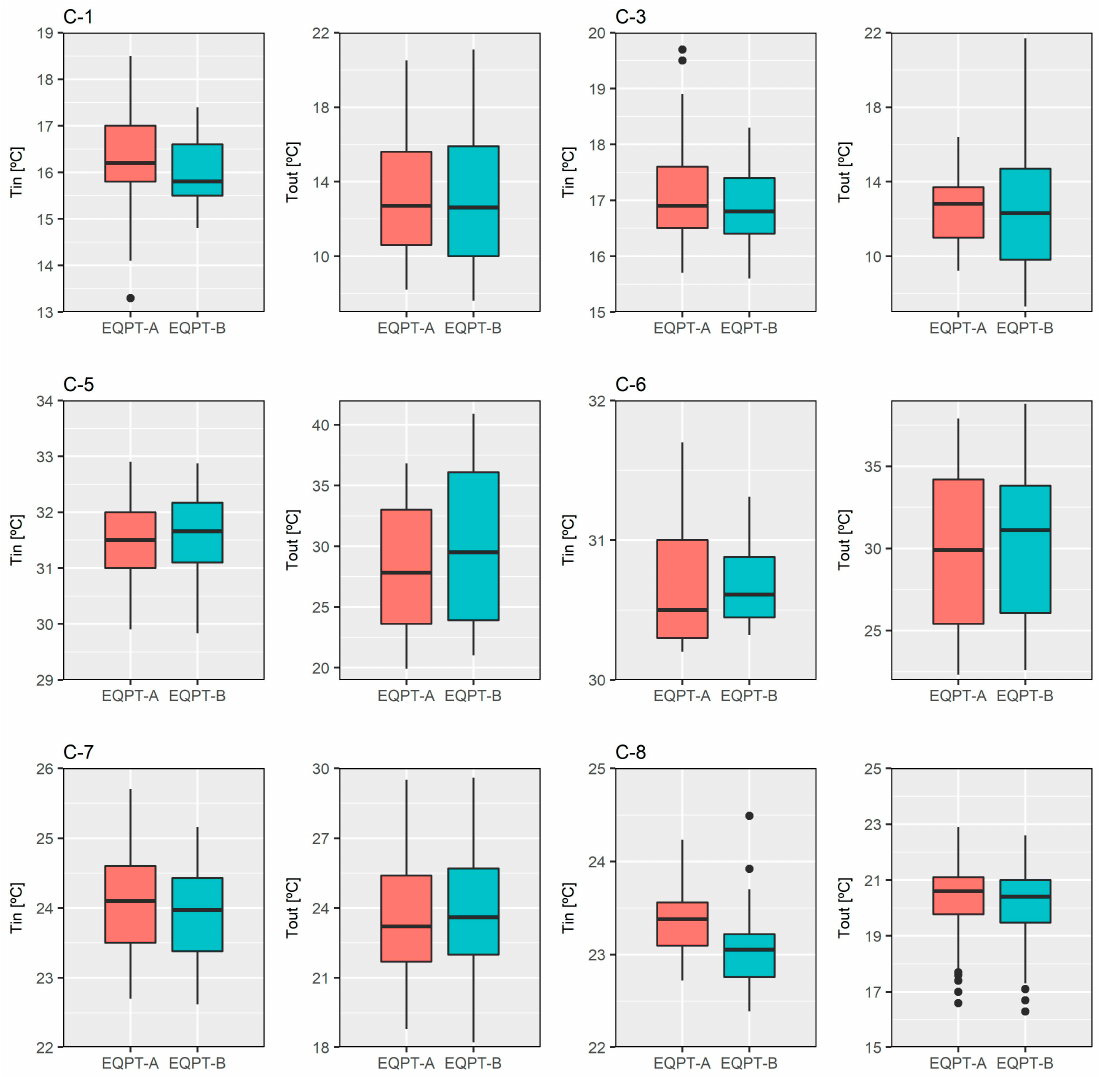
Figure 5. Box plots of the measurements of the indoor and outdoor air temperature recorded by both equipment setups. EQPT-A denotes data logger A and EQPT-B represents data logger B. The representation of case studies C-2 and C-4 is omitted due to the fact that the external probe was disconnected during the tests.